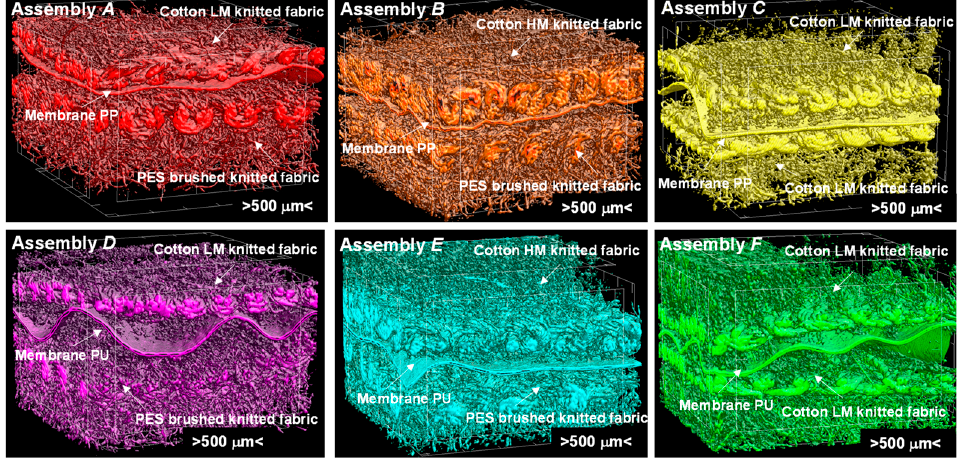
Figure 3. Micro-CT images of tested assemblies.